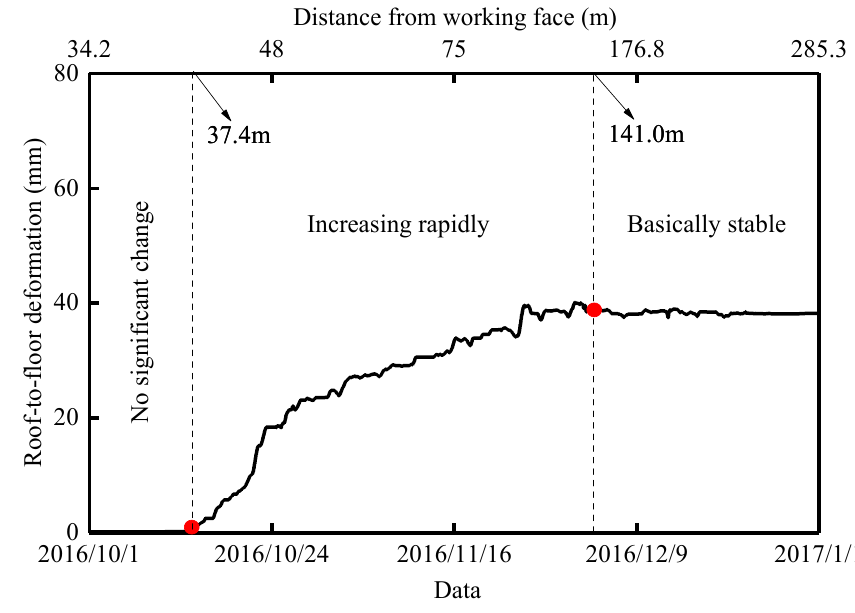
Figure 16. Roof-to-floor displacement monitoring results.